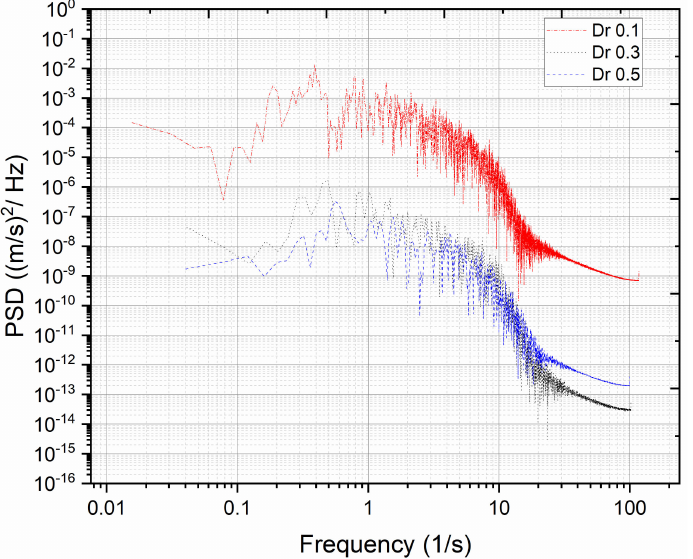
Figure 7. Power spectral density (PSD) of transverse velocity fluctuations v (cid:48) , as a function of frequency for the three depth ratios.